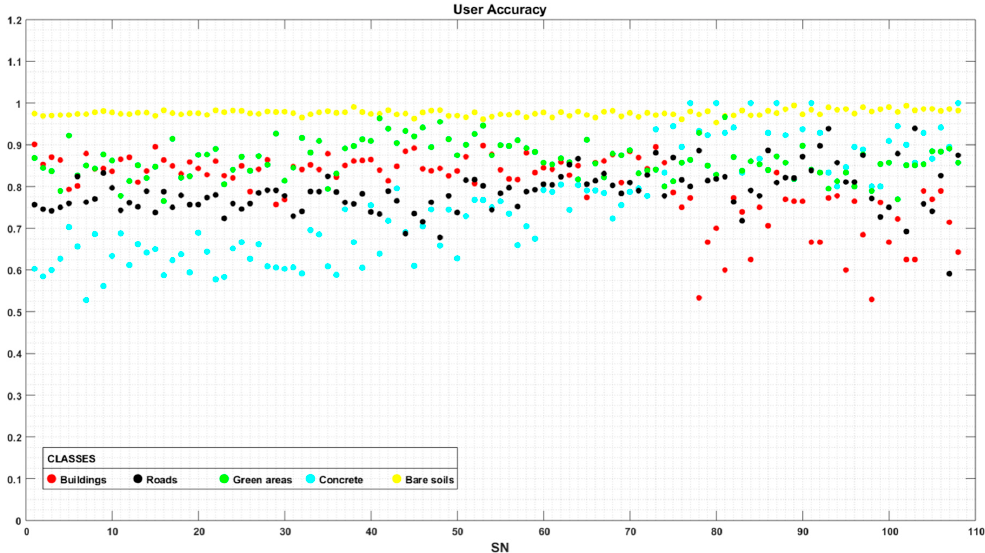
Figure 10. User accuracies for each class in classifications based on SSM 3.